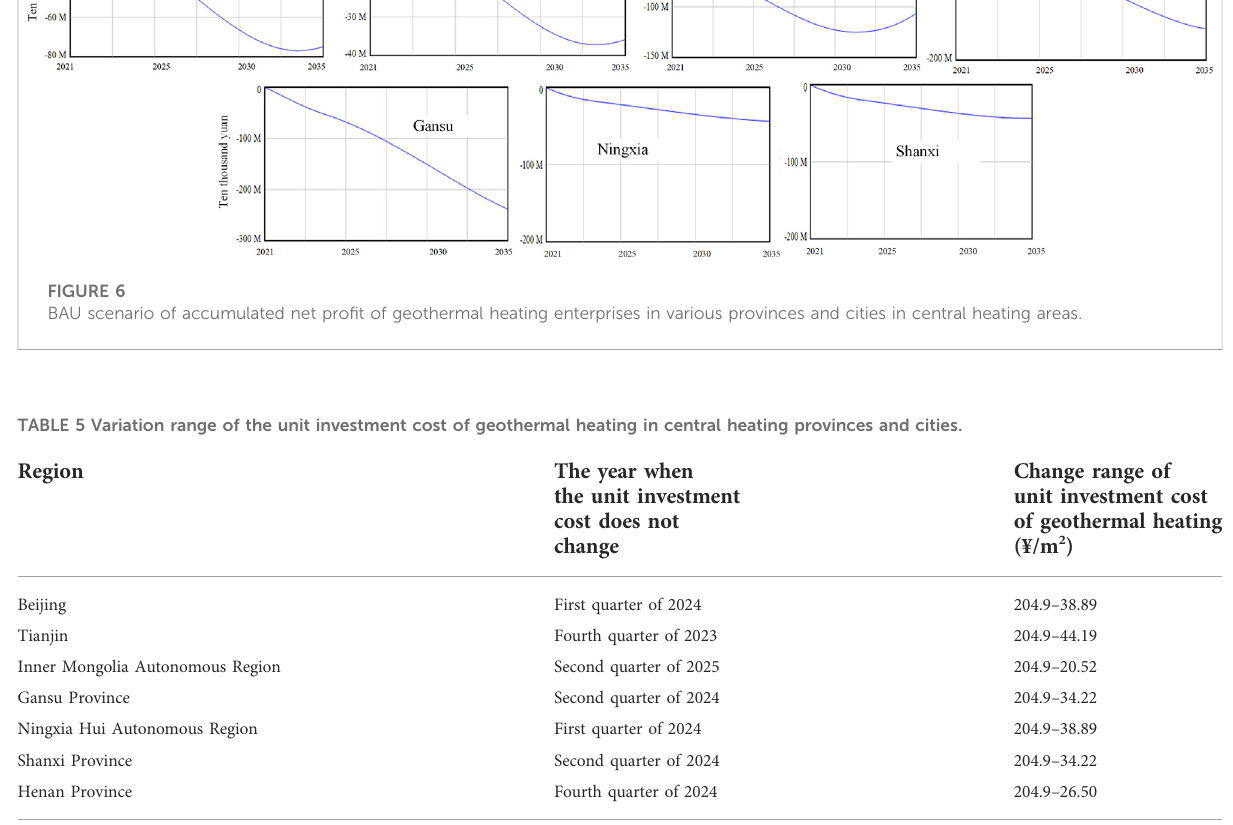
Figure 7. The horizontal axis represents the time from 2021 to 2035, and the vertical axis represents the CO 2 emission reduction. At the same time, M on the vertical axis represents millions, and B represents billions. The CO 2 emission reductions of the seven provinces and